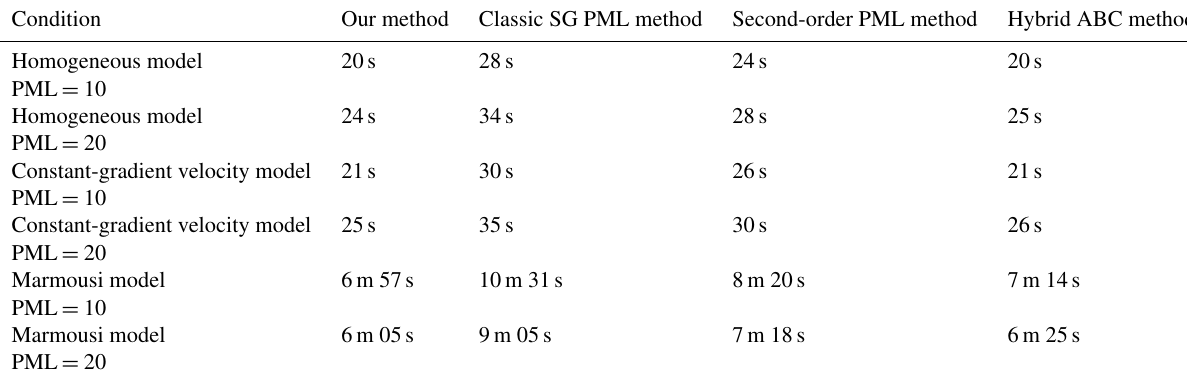
Table 2. Computation times for the four methods. Condition Our method Classic SG PML method Second-order PML method Hybrid ABC method Homogeneous